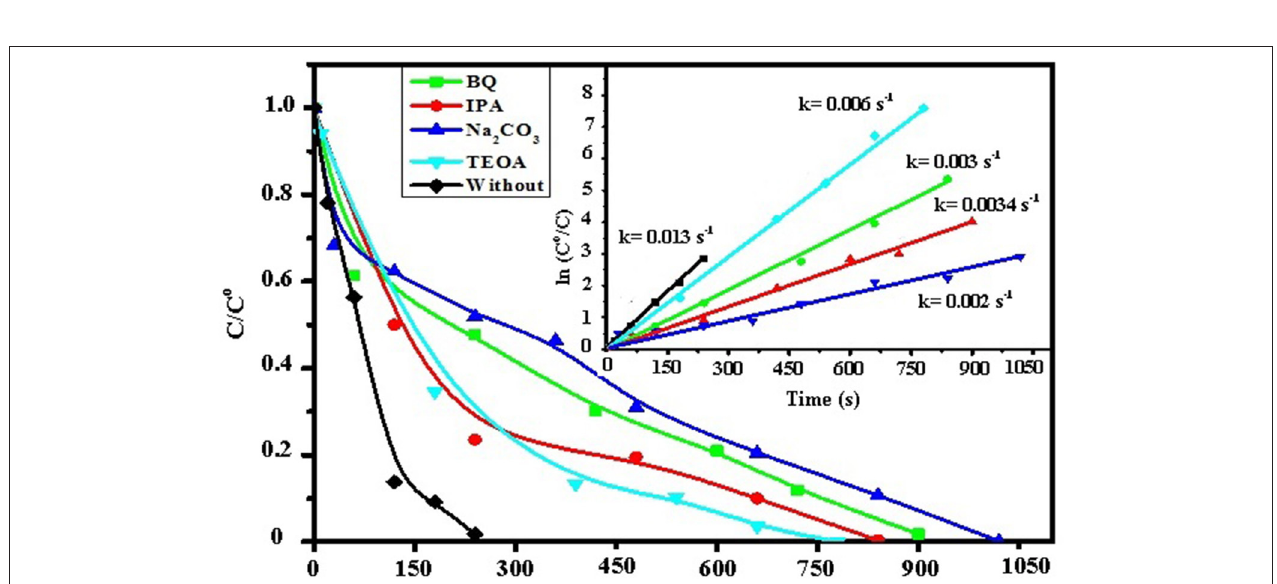
FIGURE 10 | Effect of addition of benzoquinone, isopropyl alcohol, triethanolamine and Na 2 CO 3 on the hydrogenation of 4-NP while using 4%Ag/CNT-graphene 400 together with ln C o /C against time curves as inset.